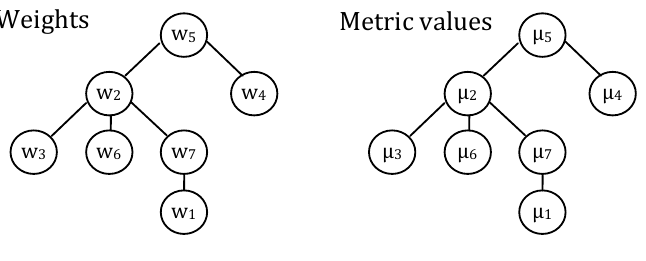
Fig 4. Illustration of node-based sentence metrics. Each node has an assigned weight and a metric value. The total value of the sentence metric is w